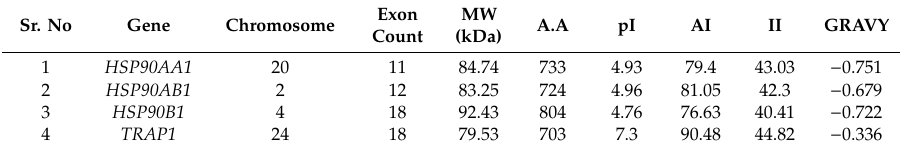
Table 4. Physiochemical Properties of HSP90 gene family members.